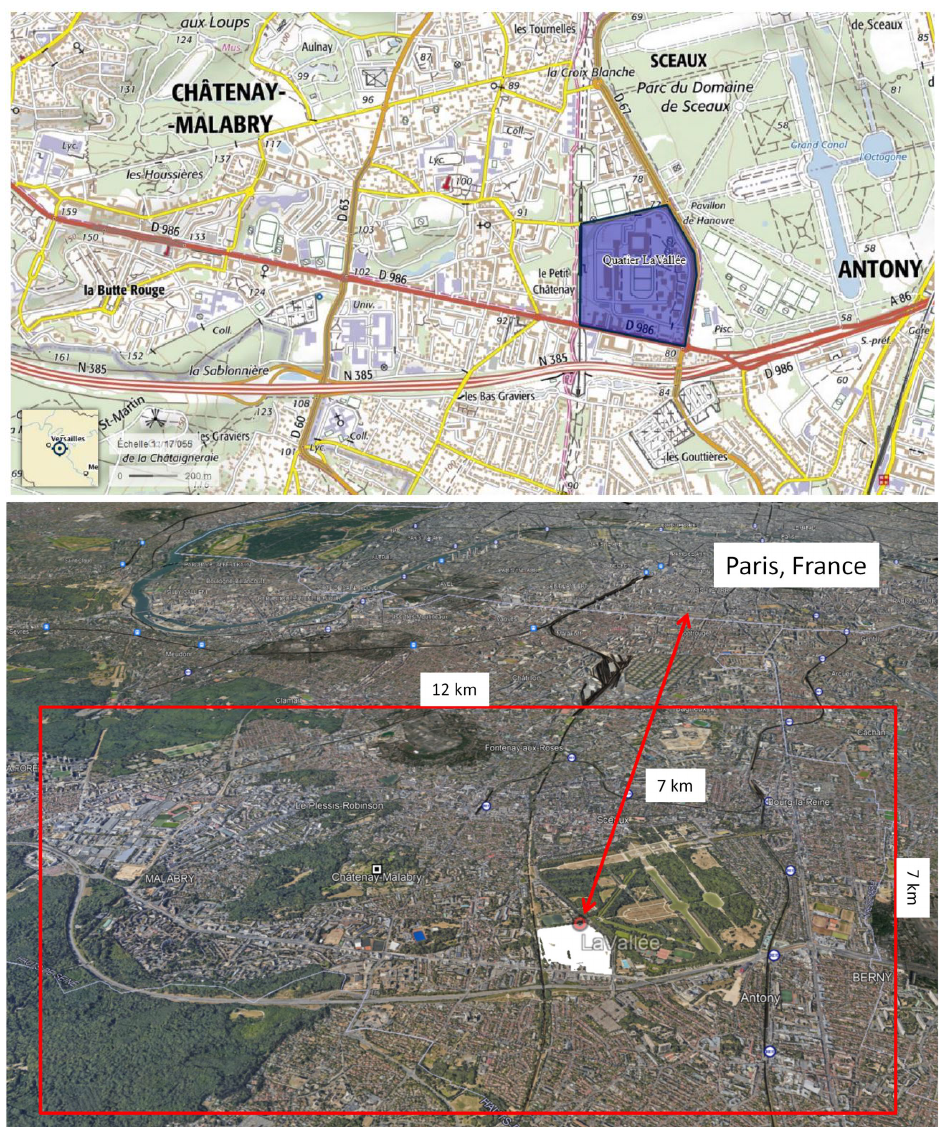
Figure 1. LaVallée district and its catchment area, a 12 × 7 km suburban area of Paris. Source: OpenStreetMap and Google